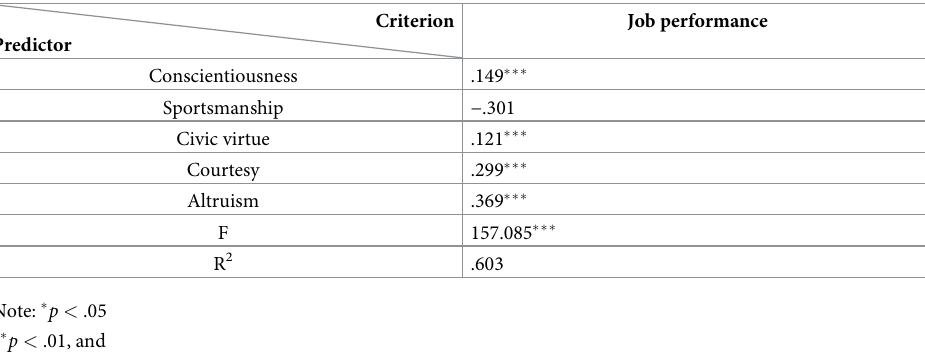
Table 4. Regression analysis of organizational citizenship behaviors and job performance.